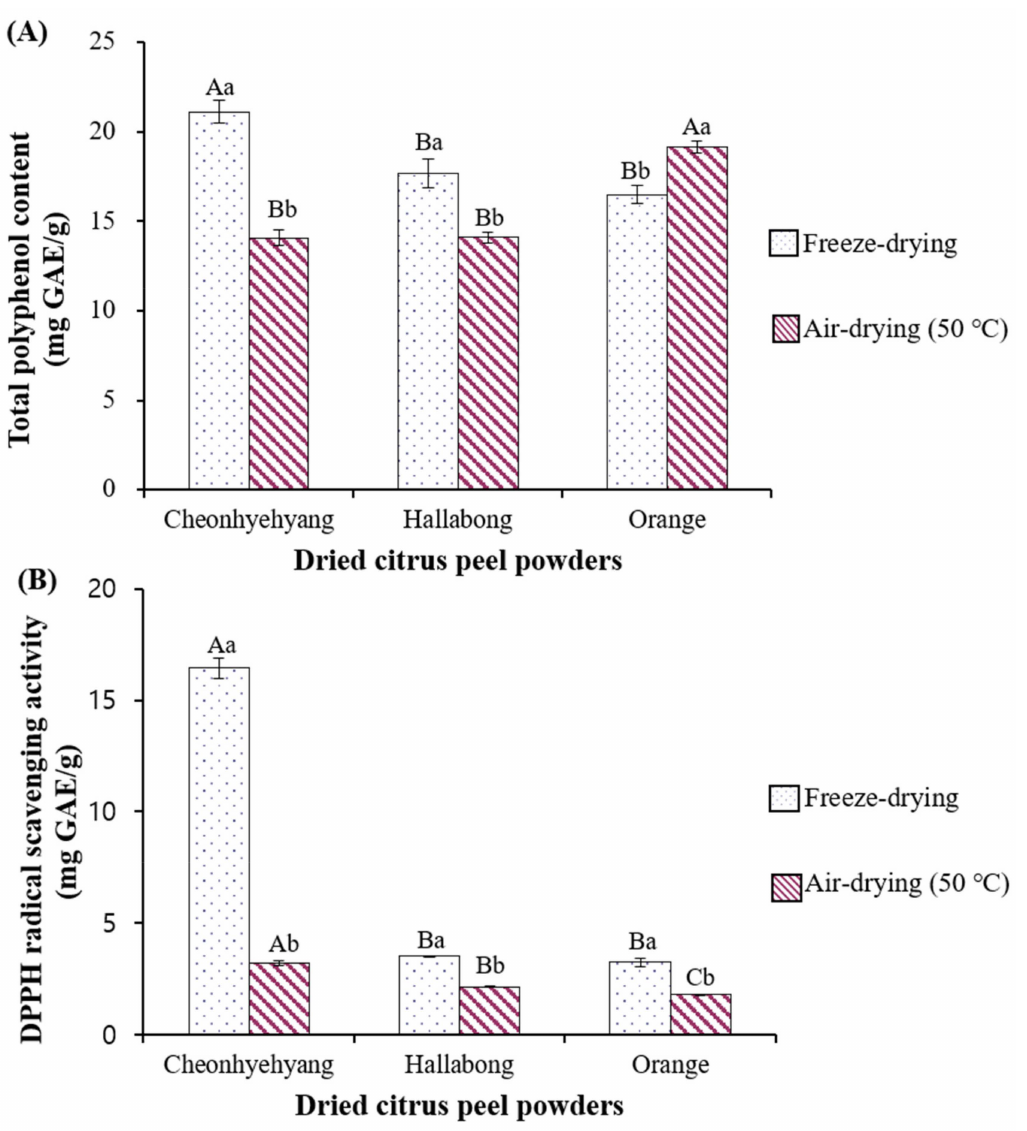
Figure 1. Total polyphenol contents and DPPH radical scavenging activity of DCPP prepared by freeze- and air-drying. ( A ) Total polyphenol contents, ( B ) DPPH radical scavenging activity). DCPP: dried citrus peel powder. Means with different capital letters on the same type bars (the same drying method) were significantly different by Duncan’s multiple range test at ( p < 0.05, A > B). Means with different small letters on the same citrus fruit species were significantly different by t -test ( p < 0.05, a >